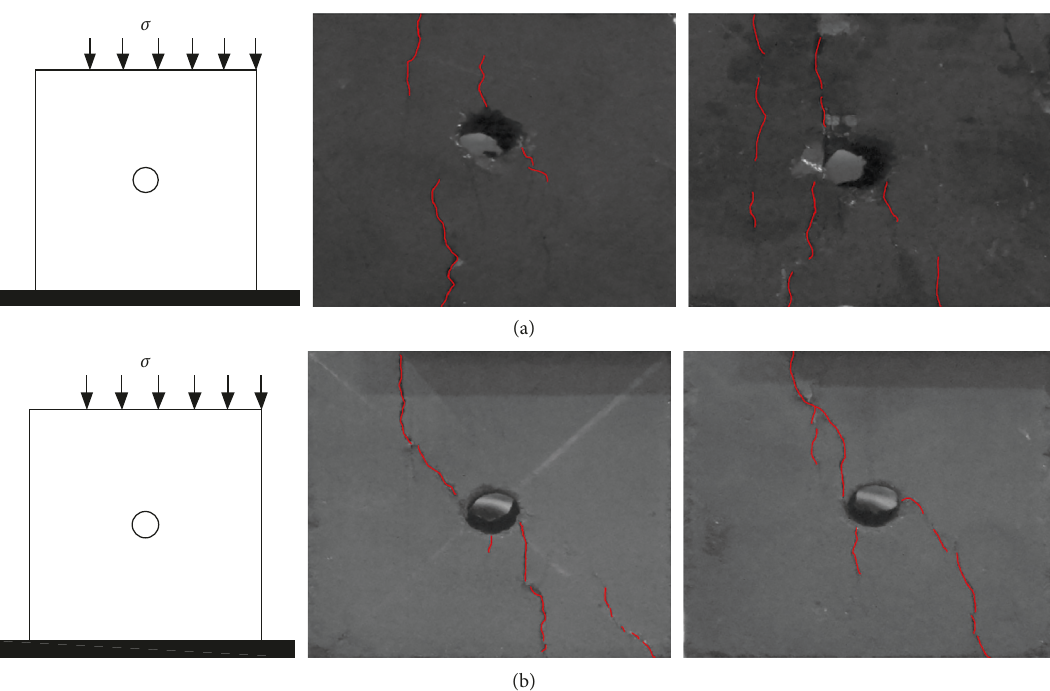
Figure 7: Action area of 3S/4. (a) Coal samples; (b) briquette